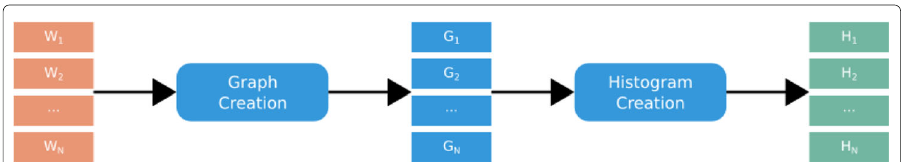
Fig. 6 Graph histogram sequence creation. First, each of the windows of the transaction sequence is transformed into a graph composed of companies and accounts. Then the graphs are transformed into histograms using their connected subgraphs